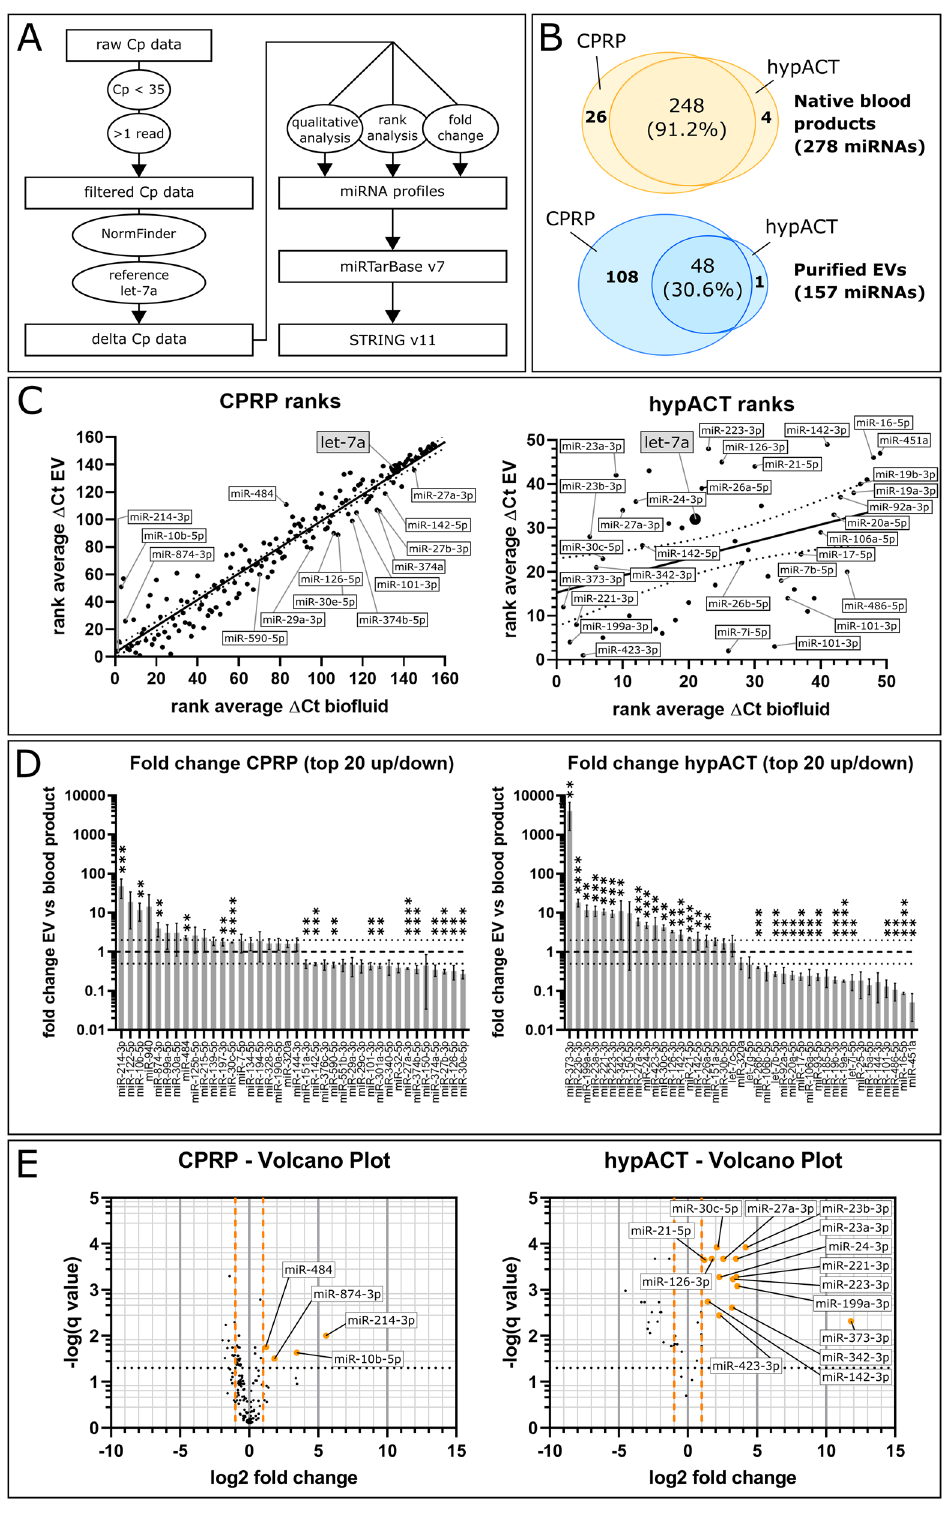
Figure 4. miRNA profiling. ( A ) RT-qPCR data analysis workflow. ( B ) Qualitative assessment of number of miRNA species identified in blood products and purified EVs. ( C ) Rank analysis of relative abundance of identified miRNAs in blood products and EVs for CPRP and hypACT, 156 and 49 miRNA species, respectively. Higher rank represents higher relative abundance. Spearman rank correlation resulted in r = 0.9592 (0.9439–0.9704 95% CI) for CPRP and r = 0.3879 (0.1113–0.6087 95% CI) for hypACT with p < 0.001 and p = 0.006, respectively. ( D ) Quantitative assessment of miRNA fold changes normalised to let-7a. Dotted black lines indicate relevance thresholds (twofold enrichment or 0.5-fold depletion). ( E ) Volcano plot of significantly enriched miRNAs. Black dotted line indicates significance threshold, orange dashed lines are relevance thresholds. Statistical significance ( D , E ) was assessed via multiple t-test accepting a false discovery rate of 5% (q < 0.05). ** p < 0.01, *** p < 0.001, **** p <